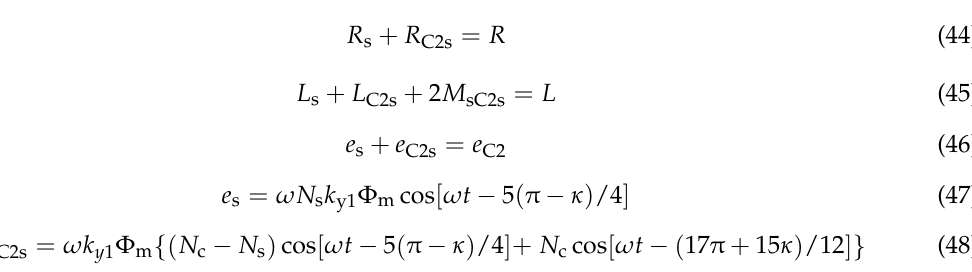
represent the resistances, inductances and